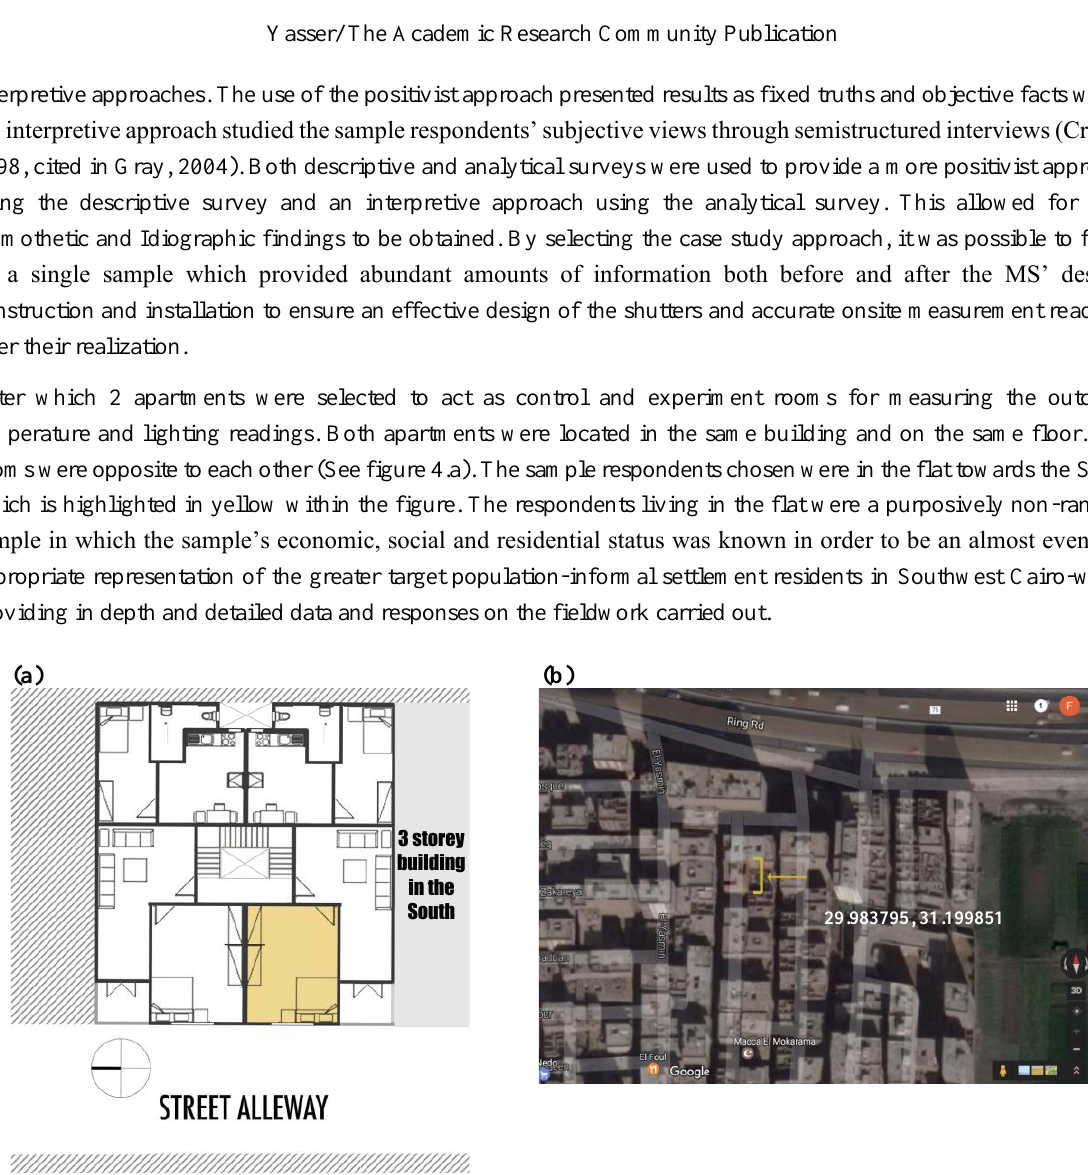
Figure 4 (b) An image from Google maps of the building location (Google maps,